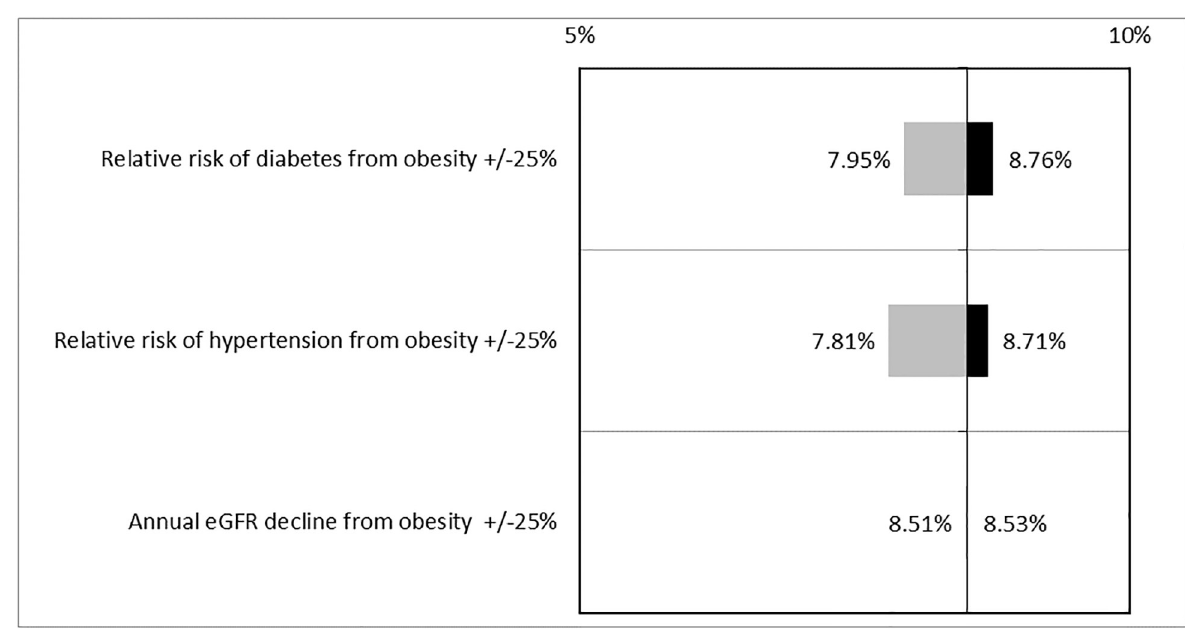
Fig 3. One-way sensitivity analysis of +/- 25% changes in key parameters on the difference in lifetime risk of any stage CKD between persons with obesity and persons with normal weight. In the main analysis, the difference in lifetime risk between persons with normal weight and obesity was 8.5%. Bars to the left of this value in the figure show the change in results if parameters are decreased by 25% and bars to the right of this value show the change in results if the parameters are increased by 25%. Abbreviations: eGFR = estimated glomerular filtration rate.